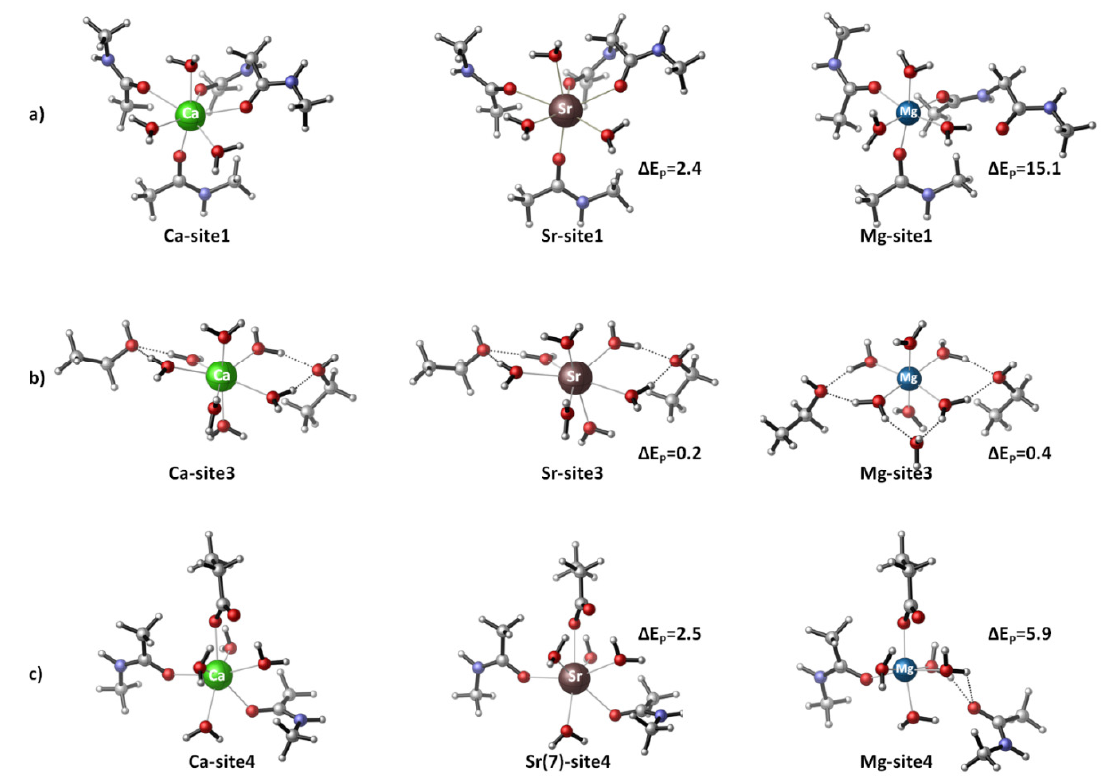
Figure 2. Fully optimized Ca 2+ , Mg 2+ and Sr 2+ -loaded metal binding sites of the active-state CaSR: ( a ) Site 1, ( b ) Site 3 and ( c ) Site 4 (drawn by CYLview visualization software [23]) and energy penalties (in kcal/mol) for Sr 2+ and Mg 2+ structures ( ∆ Ep = E(partial optimization) − E(full optimization); see text).